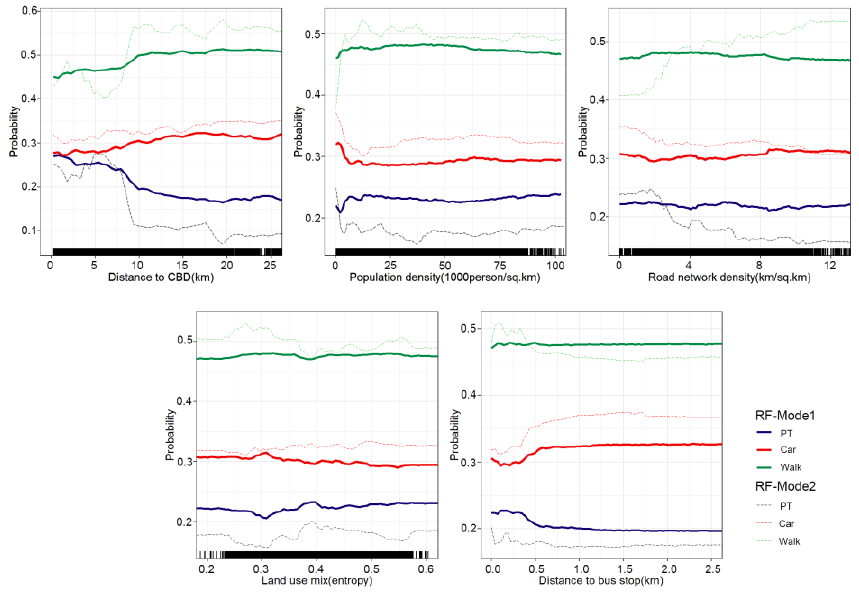
Figure 7. Nonlinear effects of built environment on travel mode choice.